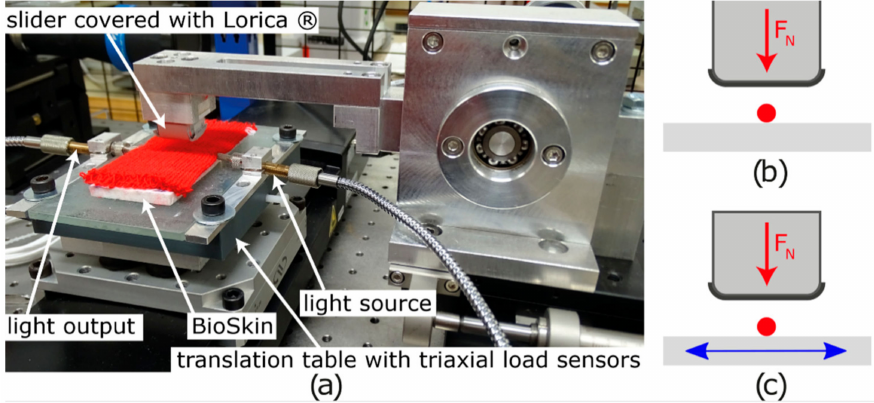
Figure 3. ( a ) Picture of the measurement system and schematization of the testing configuration for ( b ) compression tests and ( c ) friction